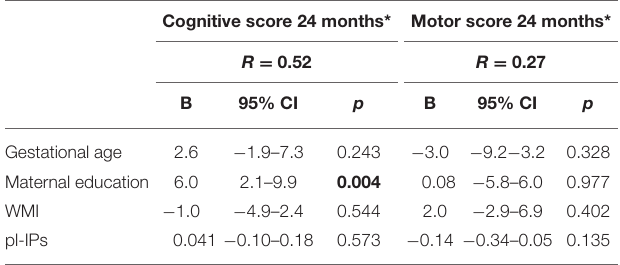
TABLE 5 | Multivariable linear regression analysis correlating pl-IPs between 24 and 48h after birth and neurological outcome at 24 months